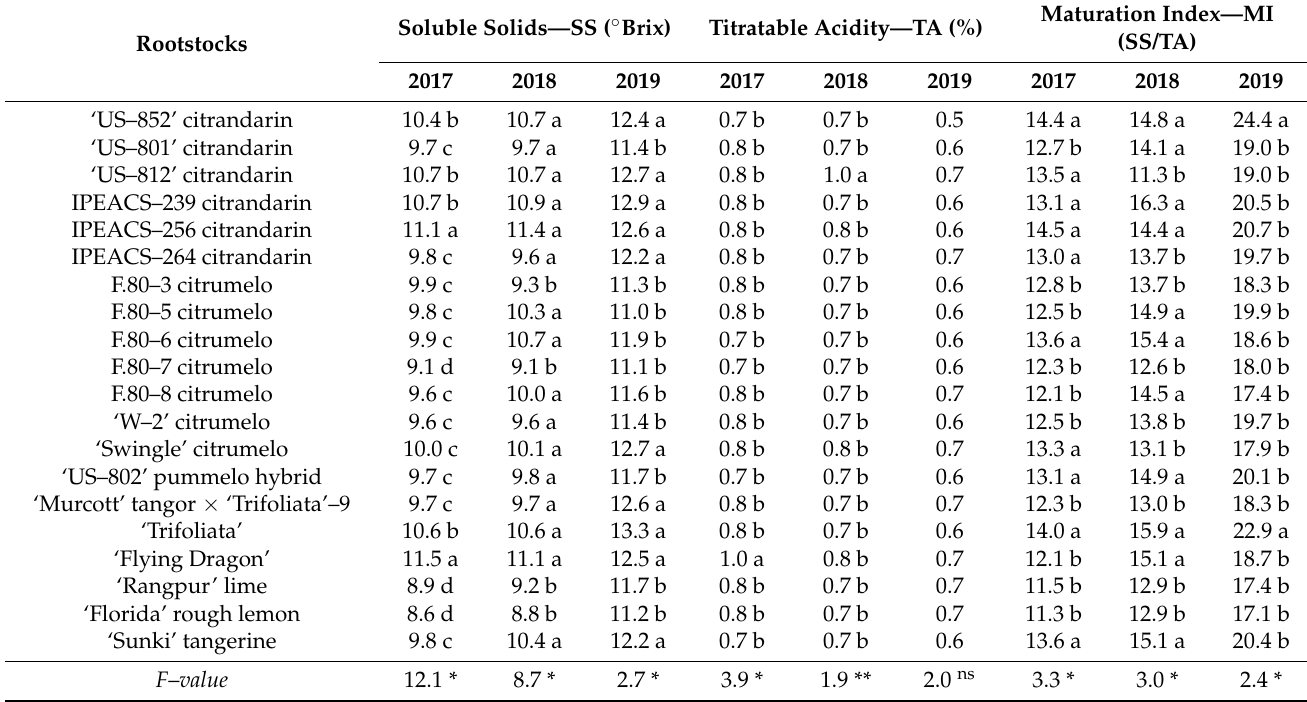
Table 4. Chemical properties of juices of ‘Valencia’ sweet orange trees grafted on 20 rootstocks. Soluble Solids—SS ( ◦ Brix) Titratable Acidity—TA Rootstocks